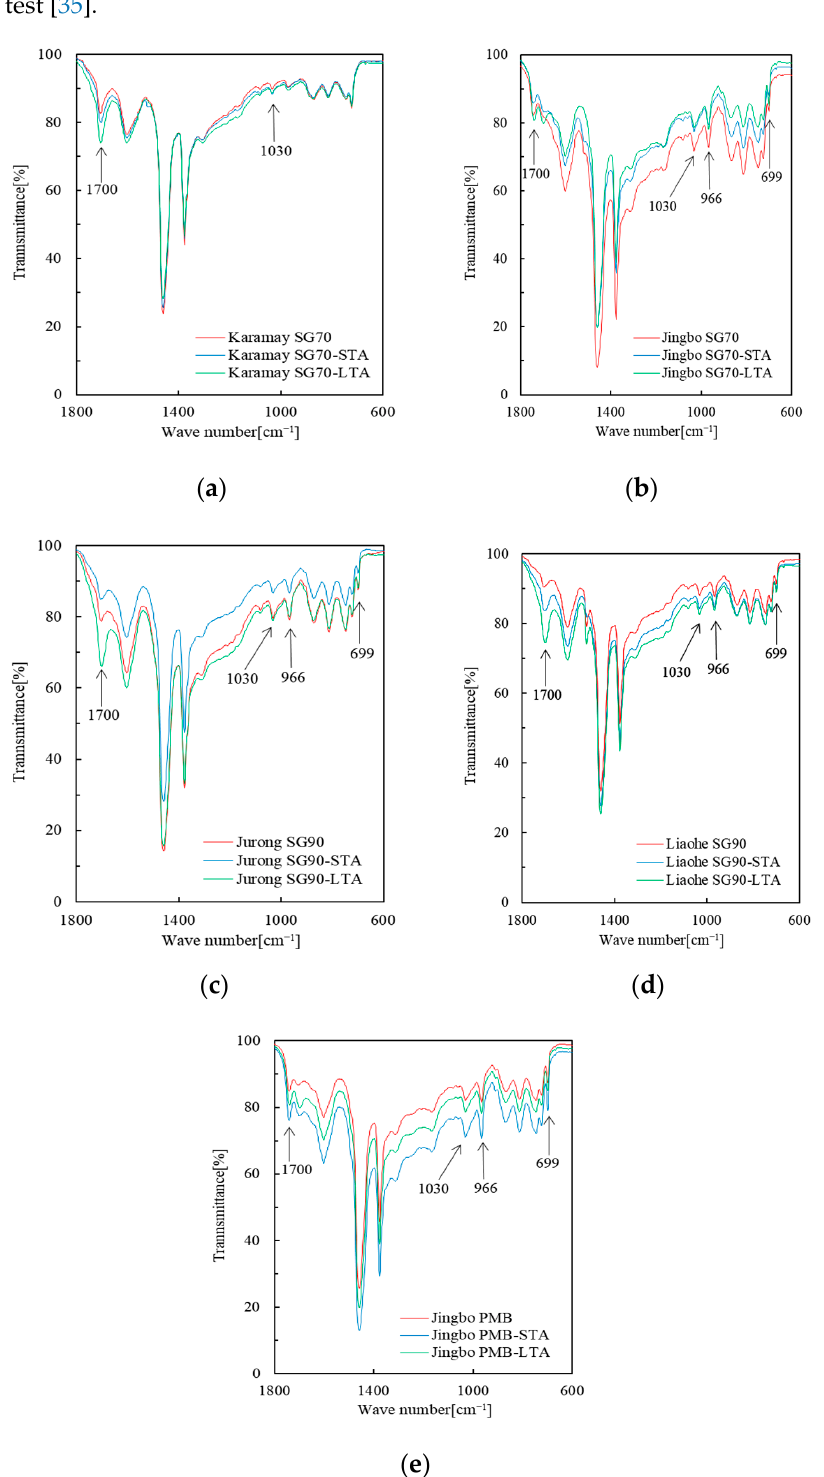
Figure 1. FTIR test results of various bitumen binders: ( a ) unaged, short- and long-term aged Karamay SG70; ( b ) unaged, short- and long-term aged Jingbo SG70; ( c ) unaged, short- and long-term aged Jurong SG90; ( d ) unaged, short- and long-term aged Liaohe SG90; ( e ) unaged, short- and long-term aged Jingbo